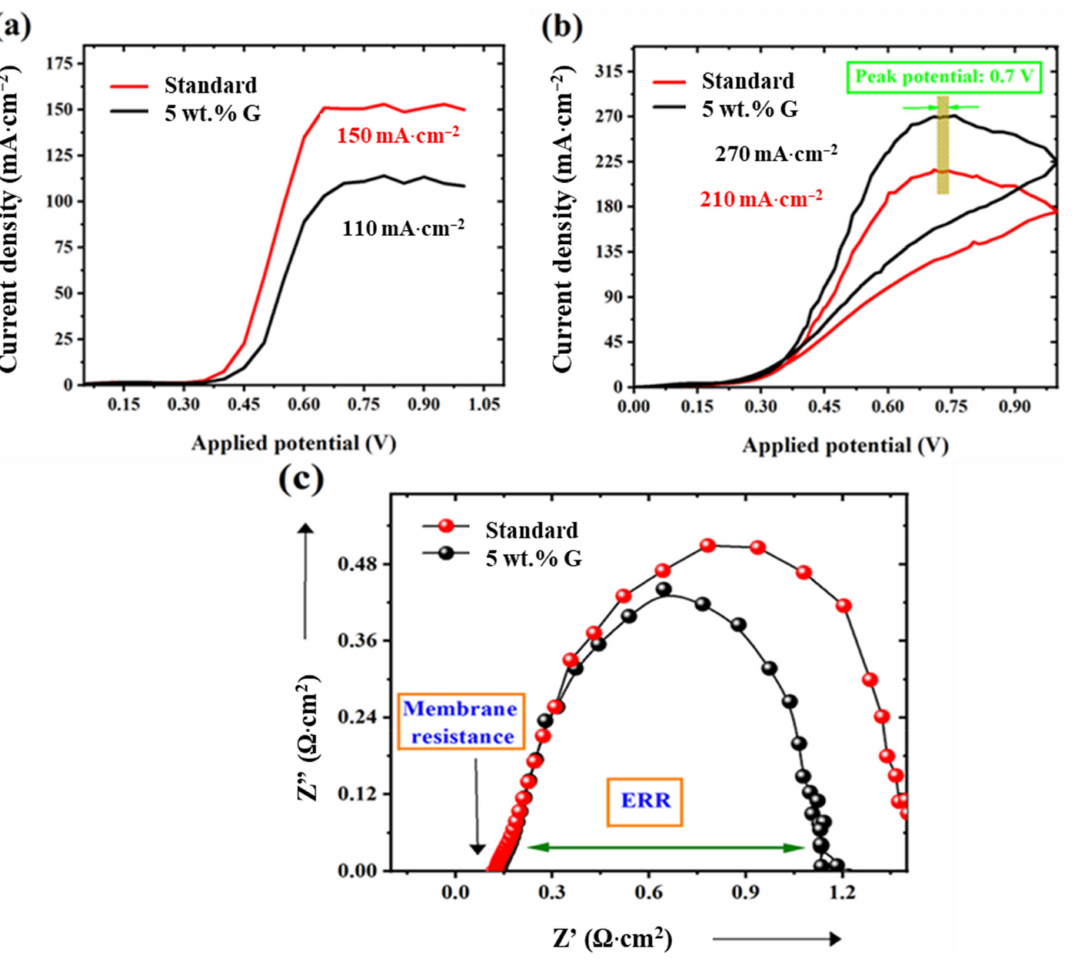
Figure 6. ( a ) Methanol crossover (by electrochemical mode), ( b ) methanol oxidation ability and ( c ) impedance spectroscopy results at 60 ◦ C in 1 M methanol conditions for standard and graphene 5 wt.% electrodes.